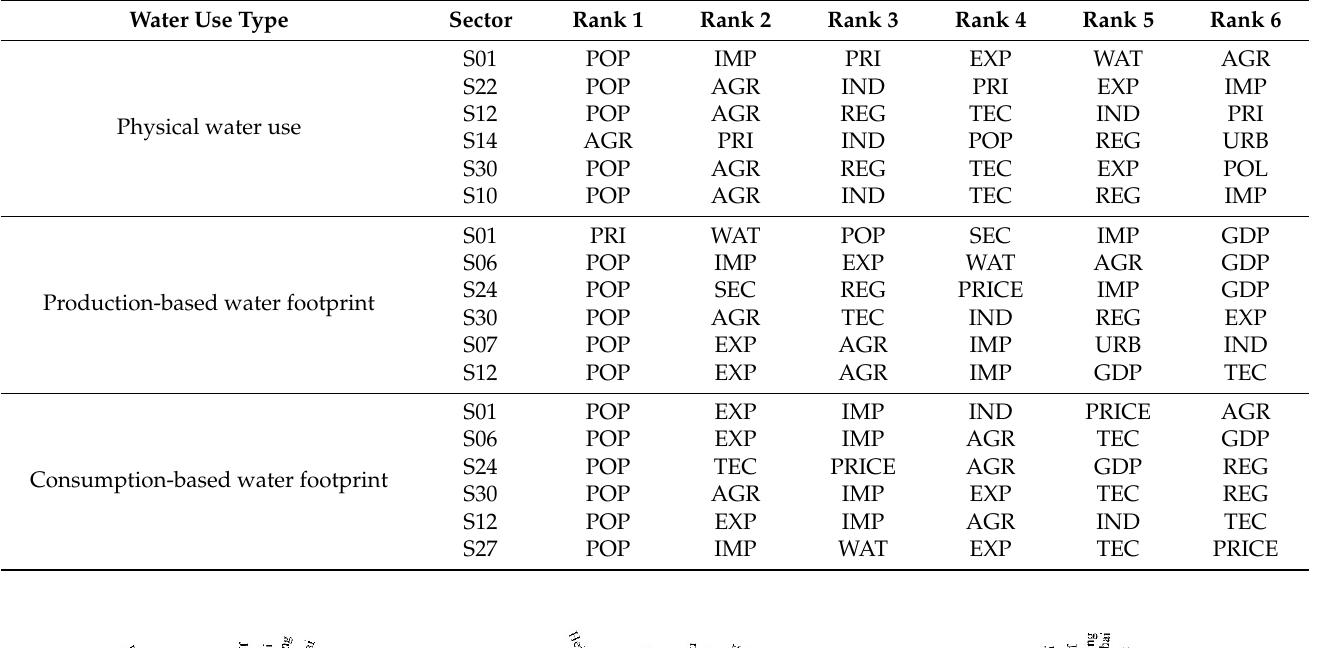
Table 2. The importance ranking of factors influencing water use in the Yellow River basin.